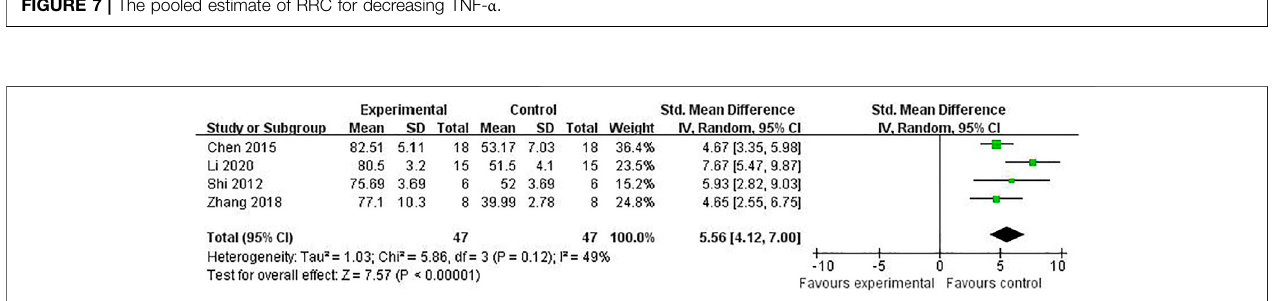
FIGURE 7 | The pooled estimate of RRC for decreasing TNF- α .